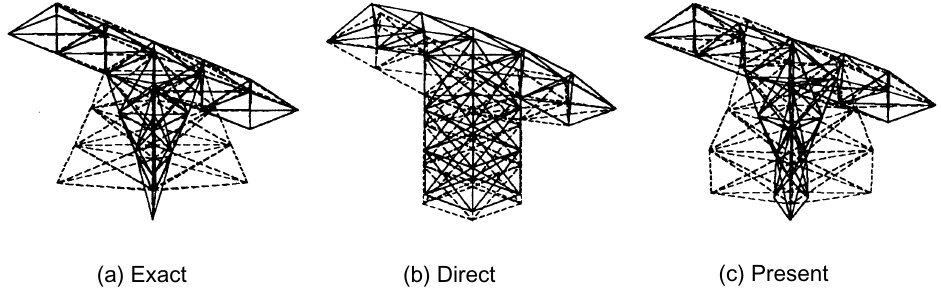
Fig. 4. First mode shape vectors of modified structure.